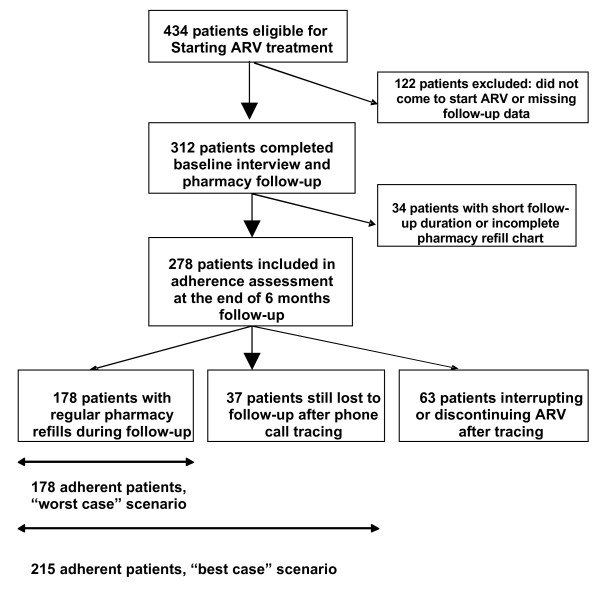
Flow chart for adherence analysis.